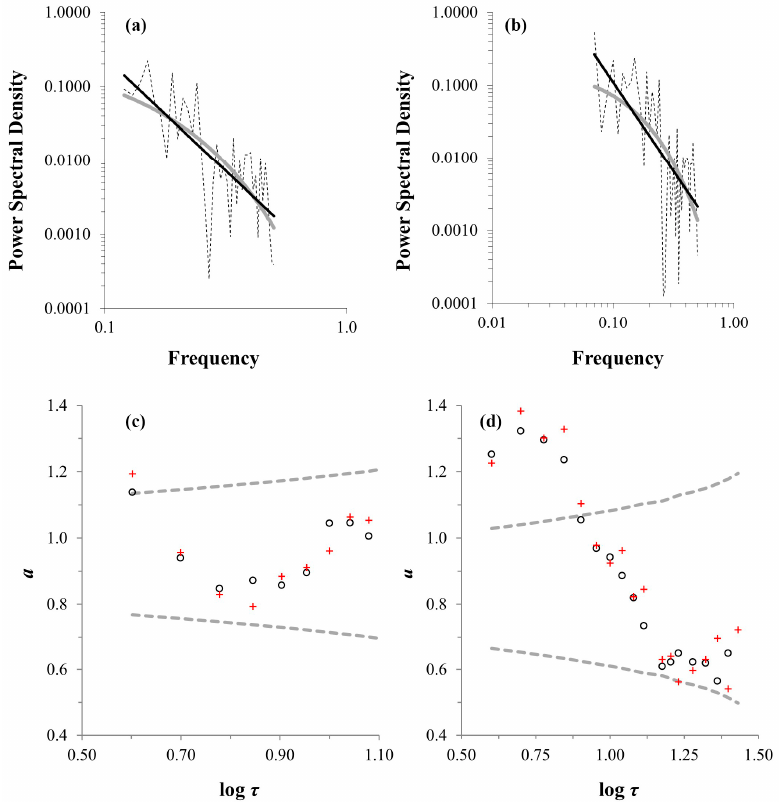
Figure 11. Power spectral density for the detrended and deseasonalized timeseries (dashed black line) of ( a ) WTD and ( b ) mean July air temperature, with the corresponding power-law (black solid line) and exponential (gray solid line) fit (for WTD: y = 2.07 · 10 − 4 · x − 3.08 with R 2 = 0.54, y = 0.28e − 10.8x with R 2 = 0.52 and for temperature: y = 3.89 · 10 − 4 · x − 2.45 with R 2 = 0.43, y = 0.19e − 9.89x with R 2 = 0.40). Local slope stability of log F d vs. log τ , calculated for an 8-point window (red crosses) and a 9-point window (black circles) for the detrended and deseasonalized timeseries of ( c ) WTD and ( d ) mean July air temperature. The dashed gray line represents the corresponding 2 σ range, derived from the 500 fractional noise